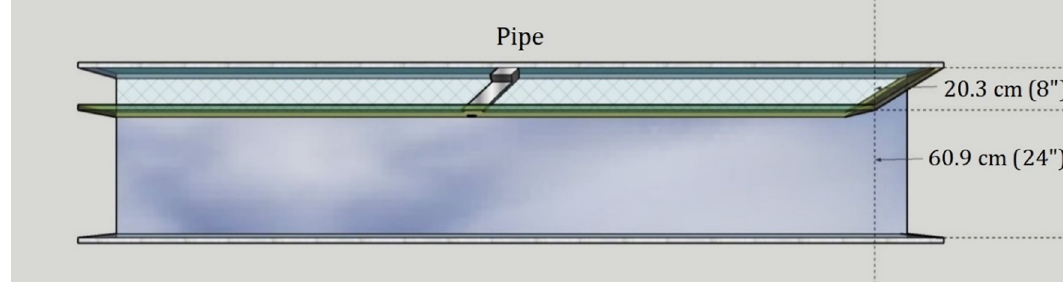
Figure 4. Wide channel configuration (top view).